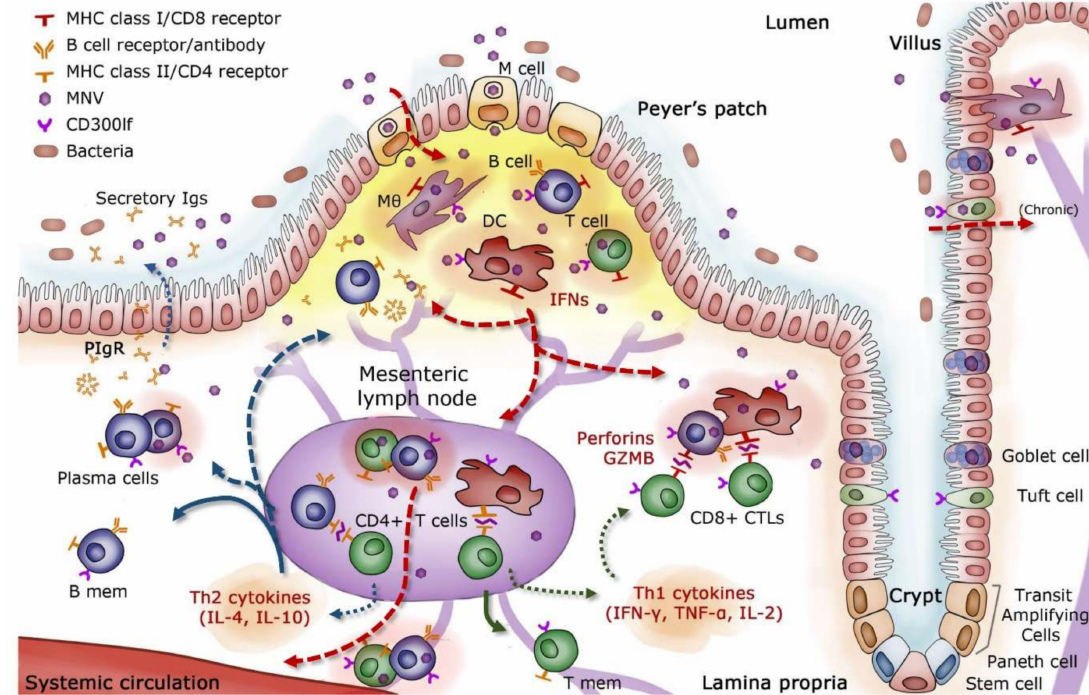
Figure 2. – Overview of proposed adaptive immune responses to murine norovirus infection in vivo. Movement of virus or virus-infected cells is marked by red dashed lines with arrows. B cell- (blue) and T cell- (green) related movement / cytokine or immunoglobulin secretion are marked by blue and green dashed lines, respectively. Maturation of memory B and T cells is marked by solid